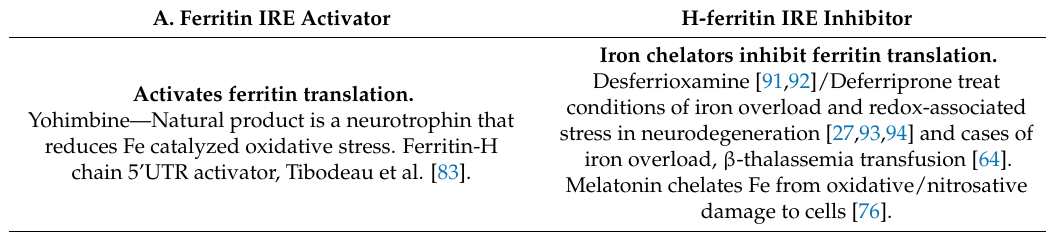
Table 3. Prion protein/H-ferritin translation modulators to shield neurons from metal toxicity. A . Therapeutic modulators of ferritin mRNAs that impact on acute iron overload and associated peroxidative redox stress to neurons. Left panel: Yohimbine is a natural product that increased ferritin 5’UTR dependent translation [83]. Right panel: Iron chelators secondarily reduce the requirement for ferritin translation as an iron storage protein. Molecules that modulate ferritin-H translation adjust iron homeostasis and improve cell-based viability. B . BL-1 is a ferritin activator that was screened as an inhibitor of an IRE in the mRNA for the 5’UTR of Prion